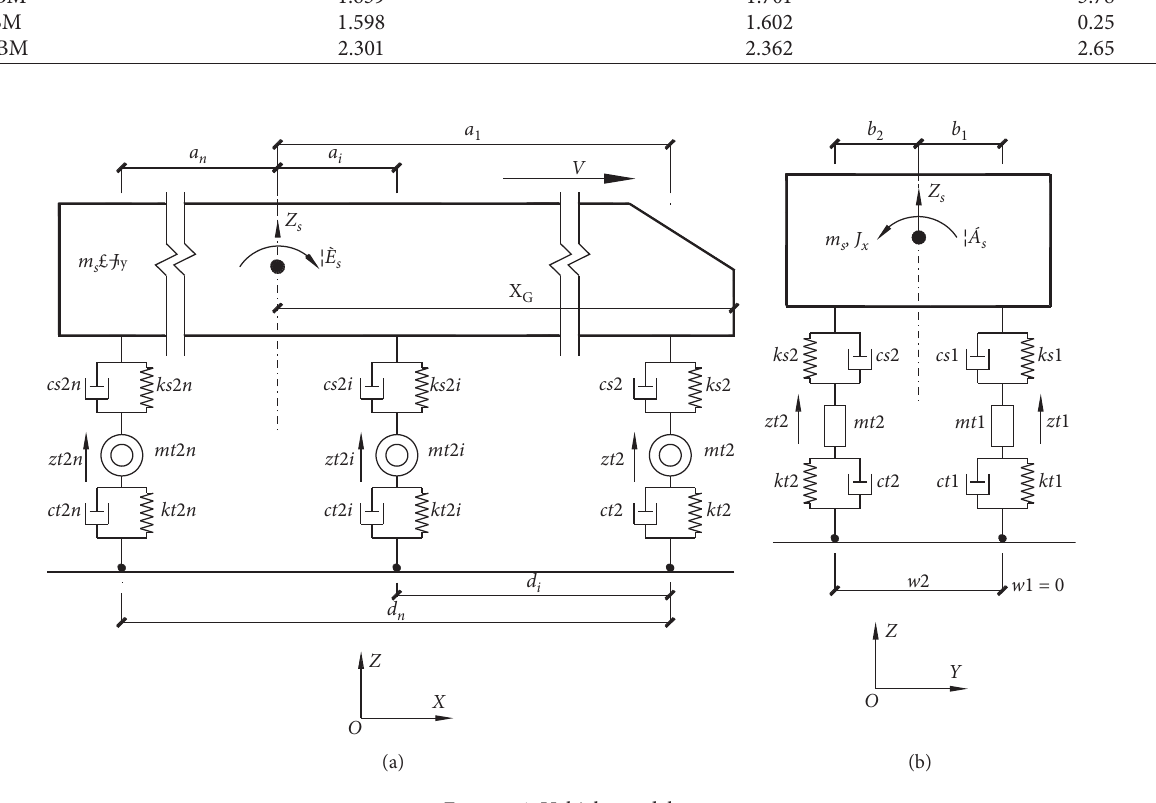
Figure 6: Vehicle